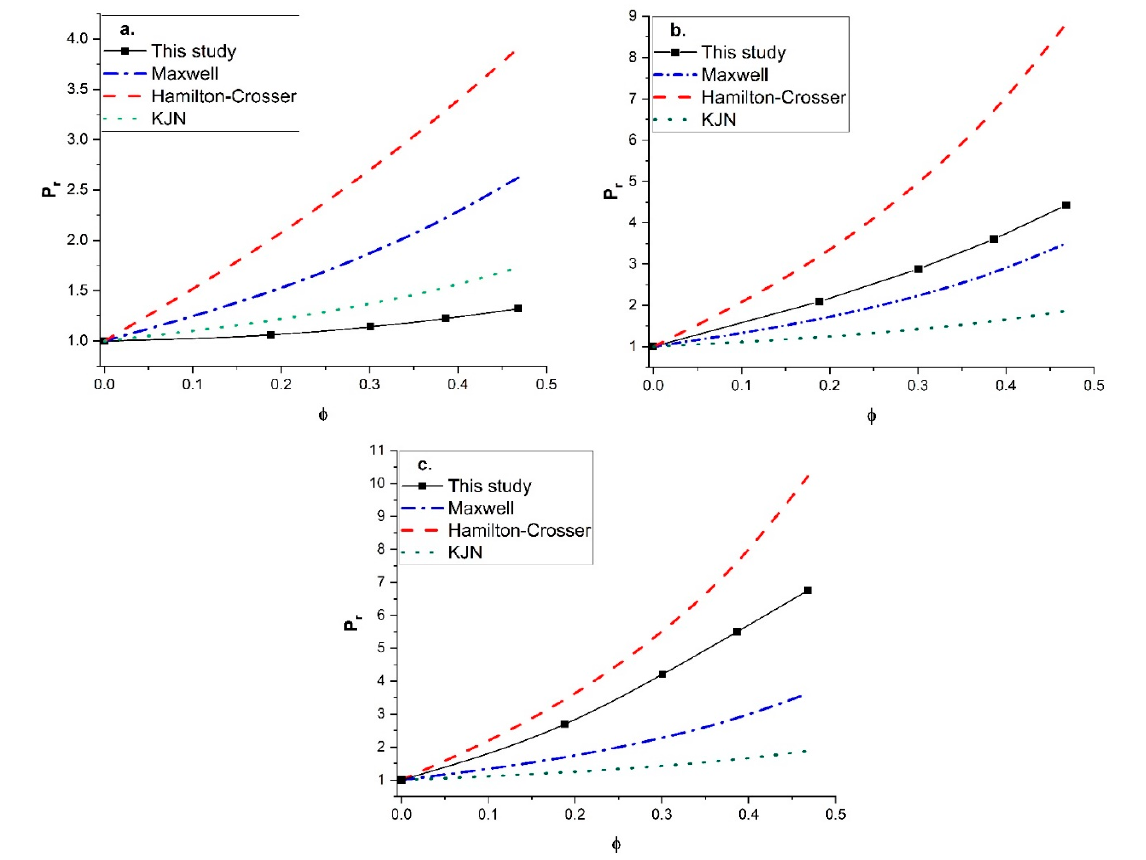
Figure 11. Comparison of the predicted relative permeability obtained in this study with the Maxwell, Hamilton-Crosser and KJN models as a function of the nanotube volume fraction for α = 100: ( a ) ( P d / P c ) = 10, ( b ) ( P d / P c ) = 100, and ( c ) ( P d / P c ) =